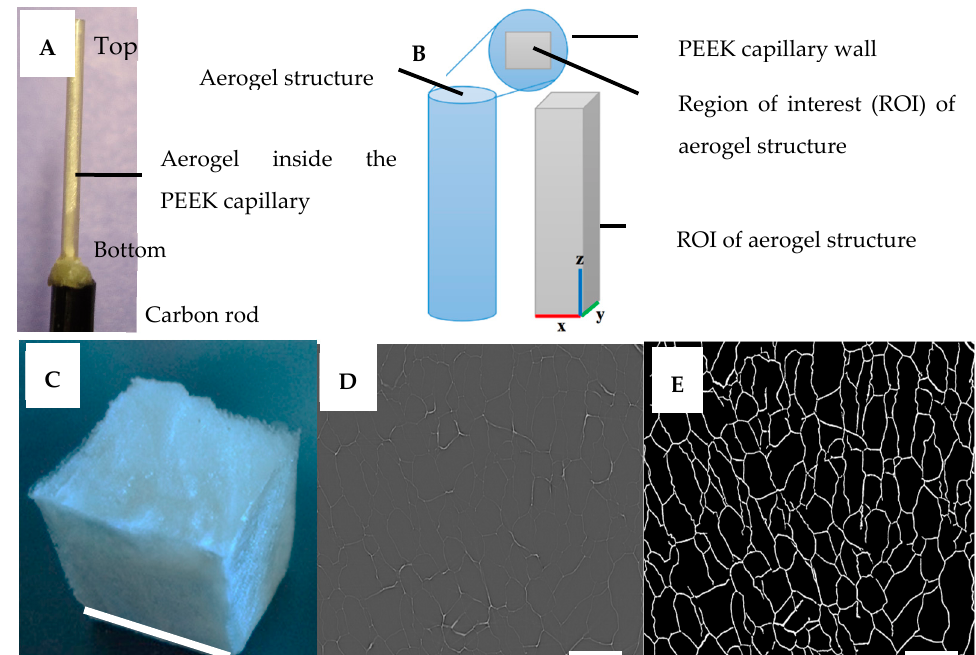
Figure 1. ( A ) Formation of aerogels inside the polyether-ether-ketone (PEEK) capillary (Diameter: 0.8175 mm); ( B ) Graphical representation of the selected region of interest (ROI) of the aerogel structure to omit the PEEK capillary wall; ( C ) Cubical aerogel; ( D ) Tomographic image from the Tomographic Microscopy and Coherent Radiology Experiments (TOMCAT) scan of a xyloglucan (XG) aerogel; and ( E ) after binarization of image D. The scale bar in C is 17 mm, and in D and E is 100 μ m. PEEK = Polyether ether ketone.